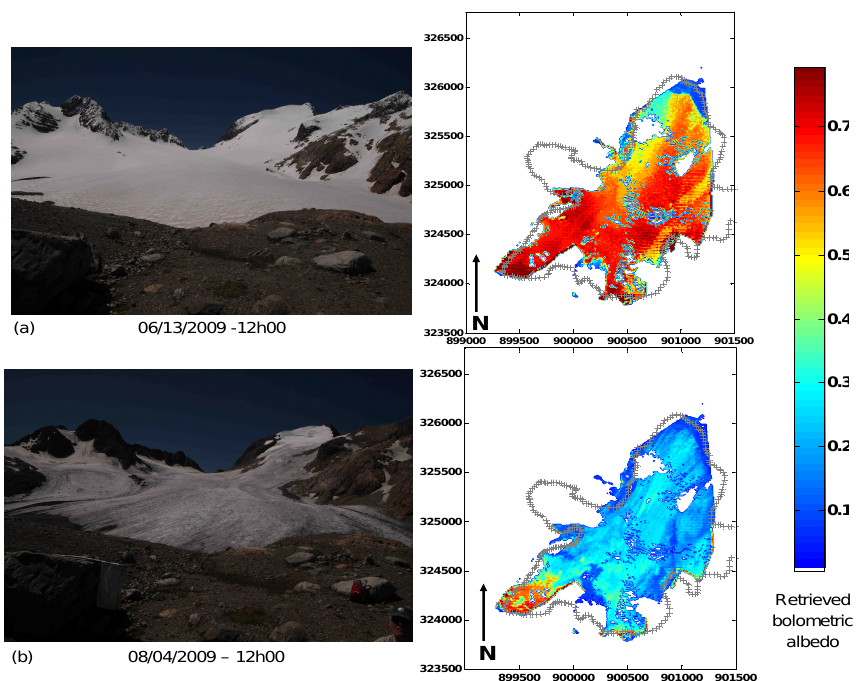
Fig. 4. Visible photography of the Saint Sorlin Glacier (left) and the derived albedo map (right) on 13 June 2009 12:00LT (a) and 4 August 2009 12:00LT (b) .